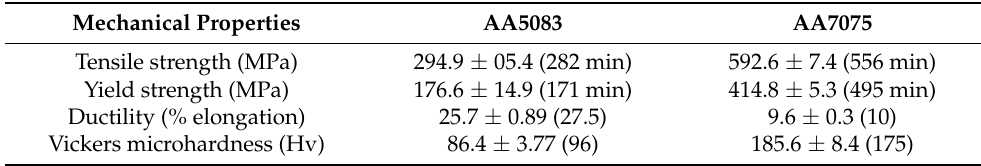
Table 2. Mechanical properties of the base